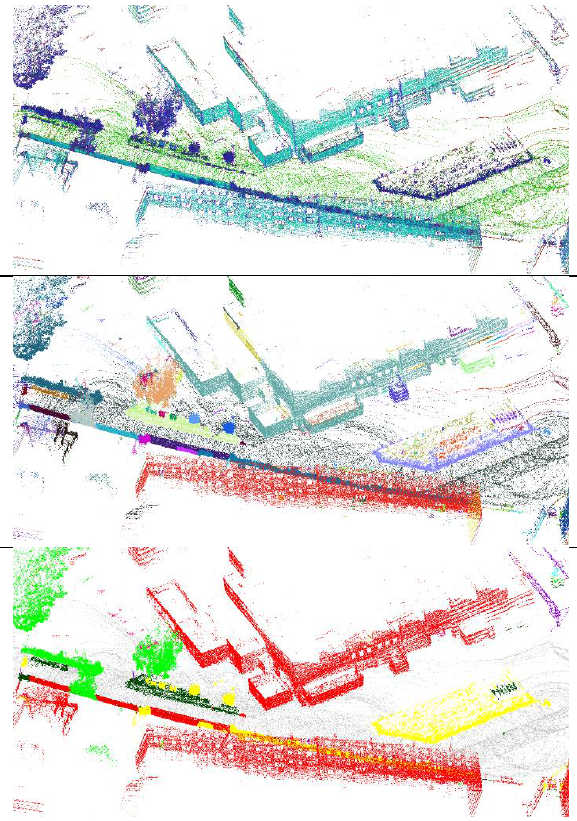
Figure 13: Multiple views of the same map (top left / light red map in Figure 11). Top: Feature response with red channel representing linearity, green channel represents planarity and blue channel represents verticality. Center: Result of the clustering process, whereby clusters are colored randomly. Bottom: Prediction result for different classes. Red: Building, Light Green: High Vegetation, Dark Green: Natural Terrain, Yellow: Low Vegetation, Gray: Man-Made Terrain, Purple: